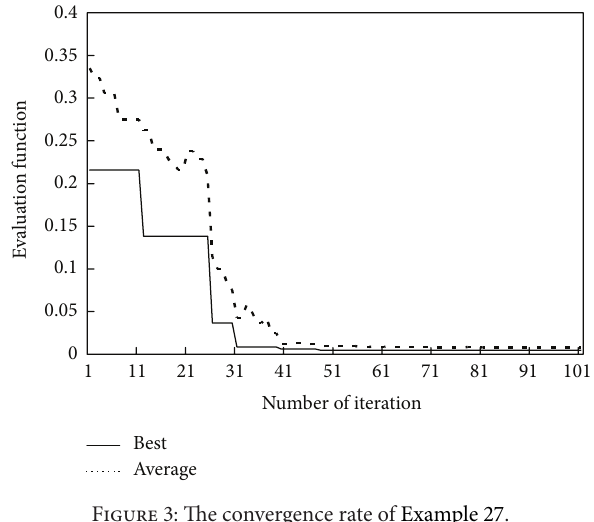
Figure 3: The convergence rate of Example